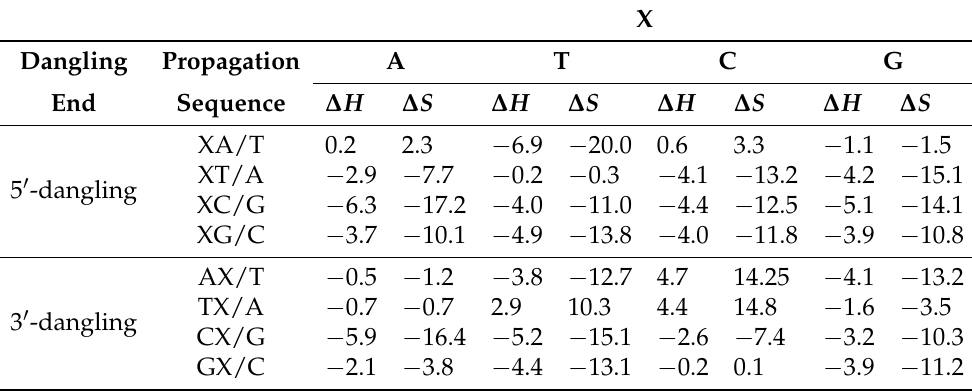
Table A2. Thermodynamic parameters for dangling ends for DNA/DNA interaction. Energy and entropy units are kcal mol − 1 and cal mol − 1 K − 1 , respectively.